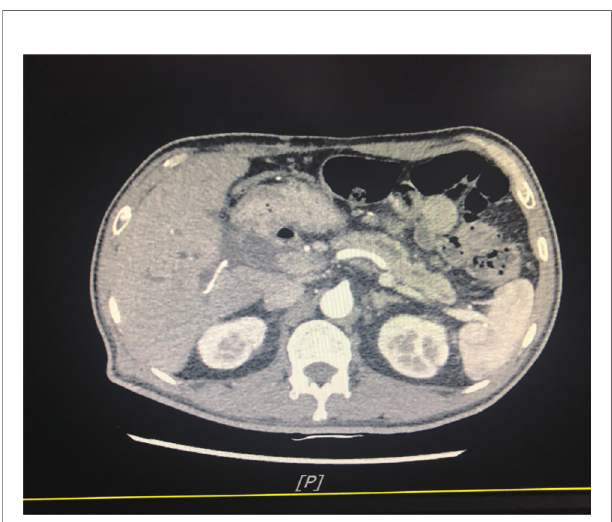
FIGURE 1 | Computed tomography shows pancreatic lesion before the